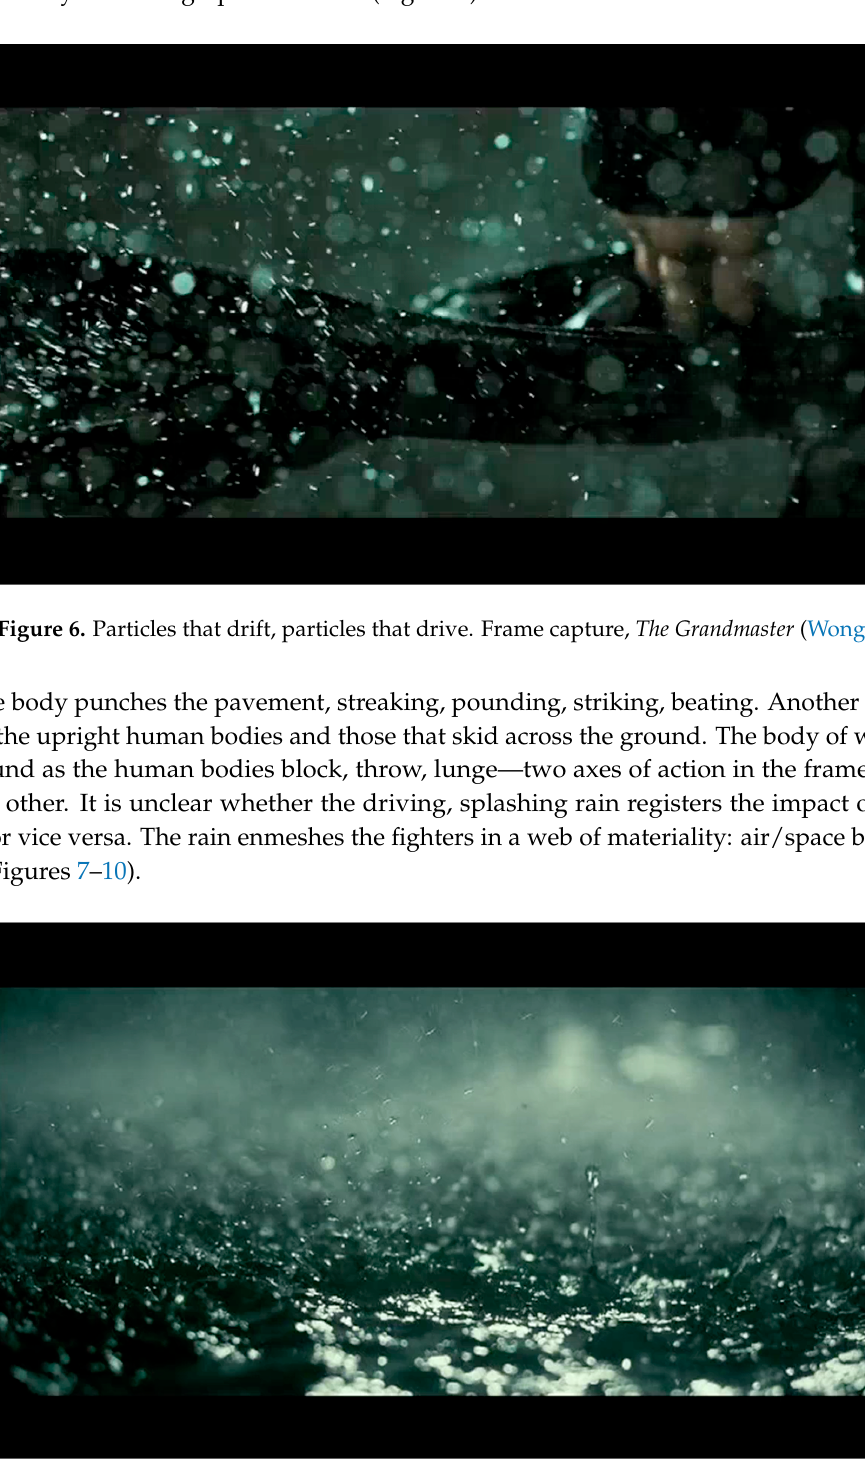
Figure 7. Rain punches the pavement, streaking, pounding, striking, beating. Frame capture, The Grandmaster (Wong 2013).